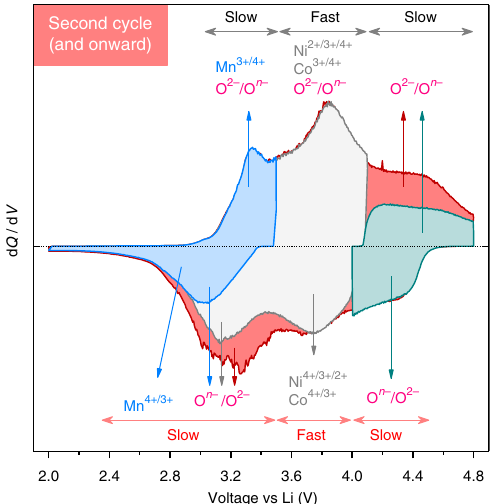
Fig. 7 Summary of activated LR-NMC ’ s charge-compensation mechanism and electrochemical kinetics. Key curves from voltage window opening experiments in Fig. 4 are superimposed on each other, keeping the same colors as before. Electrochemical kinetics is classi fi ed as either slow or fast based on impedance analysis in Fig. 5. The small Mn 3+/4+ contribution is restricted to low potentials (shaded blue) on charge with some anionic activity also. Further charge to 4.1 V (shaded gray) leads to the peak at 3.8 V mainly from cationic oxidation (Ni 2+/3+/4+ and Co 3+/4+ ) along with some anionic contribution. If charging is limited to 4.1 V, the discharge curve (shaded gray) shows two peaks, respectively, due to cationic (3.8 V peak) and anionic (3.2 V peak) reductions. If charging is continued to 4.8 V (shaded red and green), it is mainly charge compensated by anions and then the corresponding discharge capacity is split at high potential (shaded green) and low potential (3.2 V reduction peak, shaded red), thus causing hysteresis. Fast kinetics accompanies cationic redox on either charge